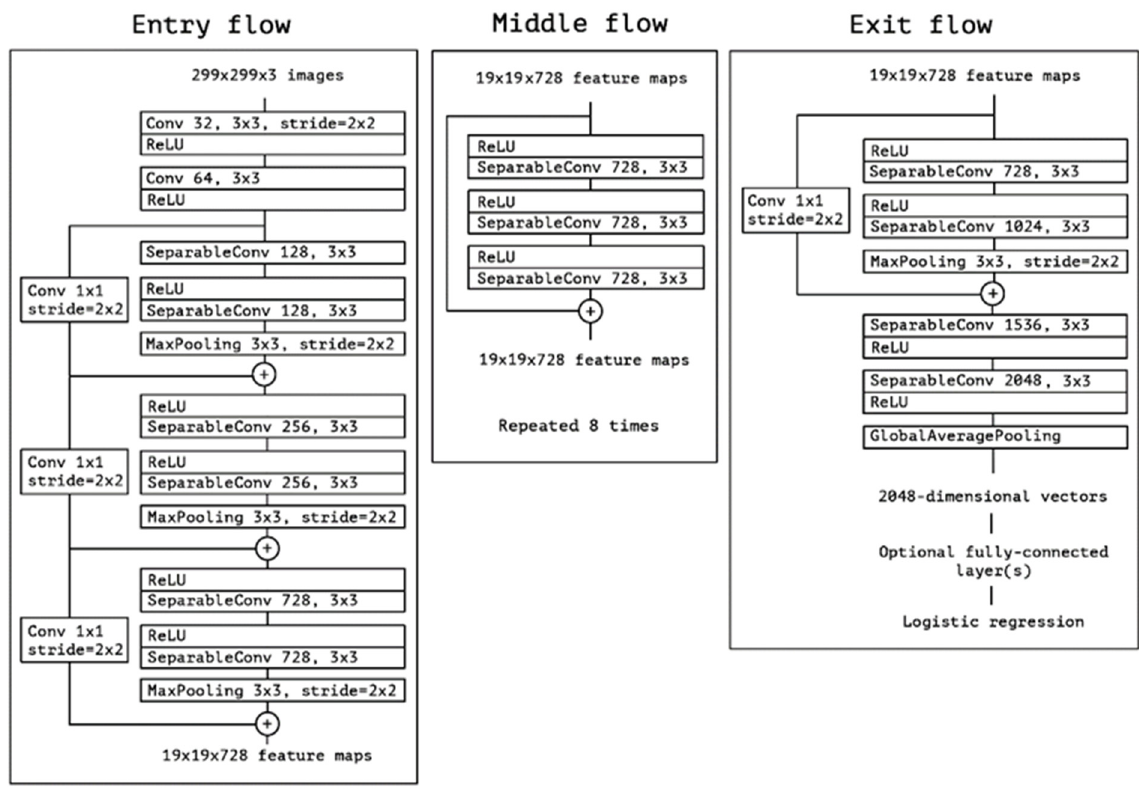
Figure 6. Architecture of Xception.